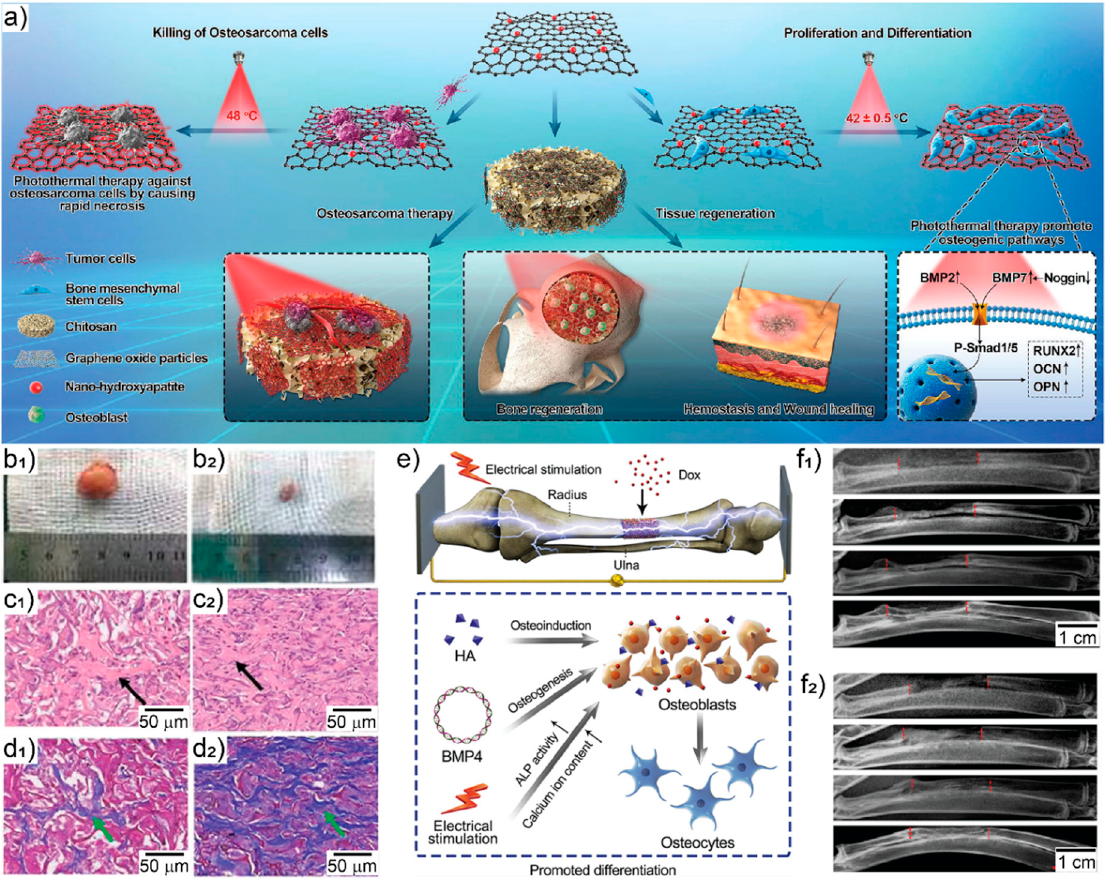
Figure 6. Synergistic approaches combining multifunctional scaffolds with energy-based therapy for TERM. ( a ) Schematic illustration of the fabrication of nHA/GO particles, nHA/GO/chitosan scaffolds, and their bioapplication. ( b 1 , b 2 ) Repre- sentative tumor photographs of control group (without adding any scaffolds or irradiation) and nHA/GO/chitosan scaf- fold implanted and daily irradiated tumors, respectively. ( c 1 – d 2 ) H&E and Masson histological analysis of the new bone formation (black arrows, new bone; green arrows, collagen fiber). ( c 1 , d 1 ) control group. ( c 2 , d 2 ) irradiated nHA/GO/chitosan scaffolds. ( e ) Construction of a smart electroactive tissue engineering scaffold with ability to control release and expression of BMP-4 for efficient bone repair. ( f 1 , f 2 ) In vivo repair of smart electroactive polymer scaffolds. X-ray detection of rabbit radial defect implanted with PLGA/HA scaffold without electrical stimulation ( f 1 ) and PLGA/HA/PLA-aniline pen- tamer/BMP-4 scaffold with electrical stimulation ( f 2 ). Four images from top to bottom were collected in 2-, 4-, 8-, or 12- weeks postoperation for each group. ( a – d 2 ) adapted with permission from [177] , Elsevier, 2019. ( e – f 2 ) adapted with per- mission from [179] , Elsevier, 2019. More sophisticated approaches have been reported by combining multifunctional scaffolds with more than one aiding therapy. In reference [180], Leppik et al. studied the combination of β -TCP scaffolds, adipose tissue derived MSCs (AT-MSCs) and electrical stimulation as a possible treatment for large bone defects. The authors found increased osteogenic gene expression and differentiation in vitro with the electrical stimulation of the AT-MSCs + β -TCP. Moreover, in vivo rat femur defects treated with AT-MSCs + β - TCP scaffold and electrical stimulation presented improved bone healing as seen by the greater amounts of new bone and vascularization, less fibrous tissue, increased osteogenic gene expression and bone strength. In another approach, Gelmi et al. developed PLGA fiber scaffolds coated with the conductive polymer polypyrrole for delivery, support and electro-mechanical stimulation of induced pluripotent human stem cells (iPCS) for cardiac tissue engineering [181]. Electrical stimulation led to reversible volume changes of